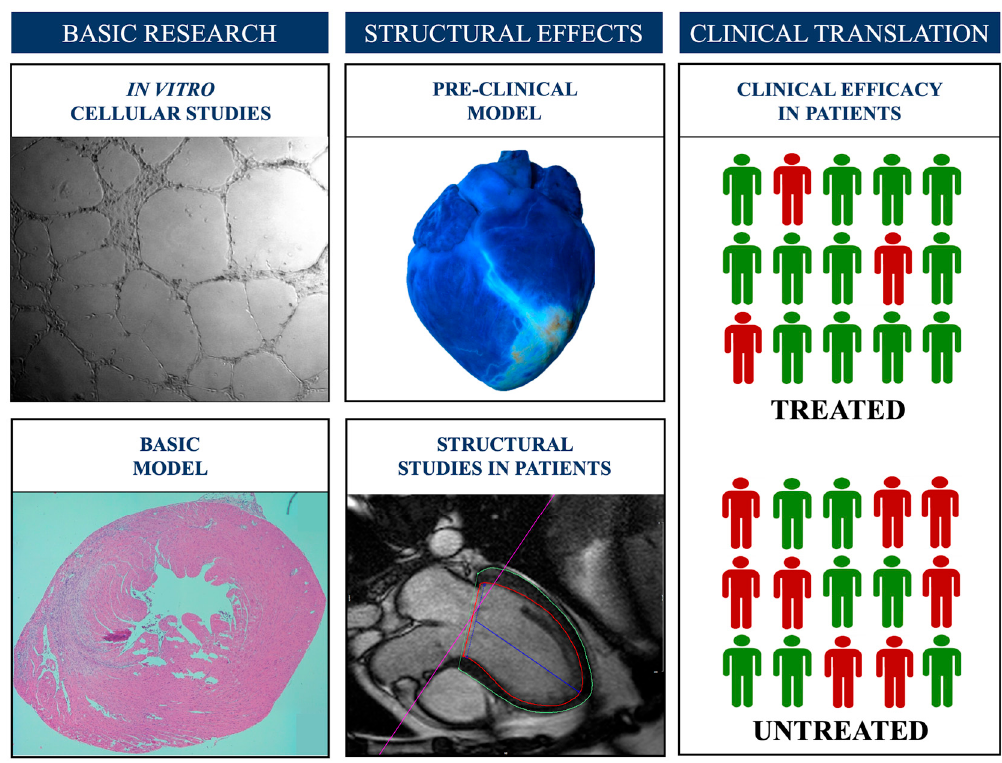
Figure 5. The proposed research steps in the development of novel therapeutic opportunities to prevent, minimize, or repair microvascular obstruction following myocardial